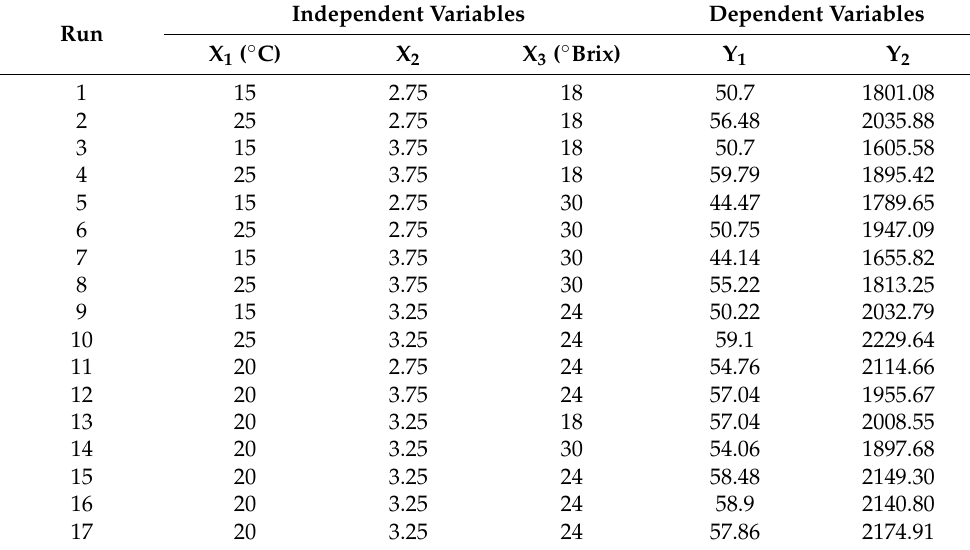
Table 2. The central composite design matrix and experimental values. Independent Variables Dependent Run